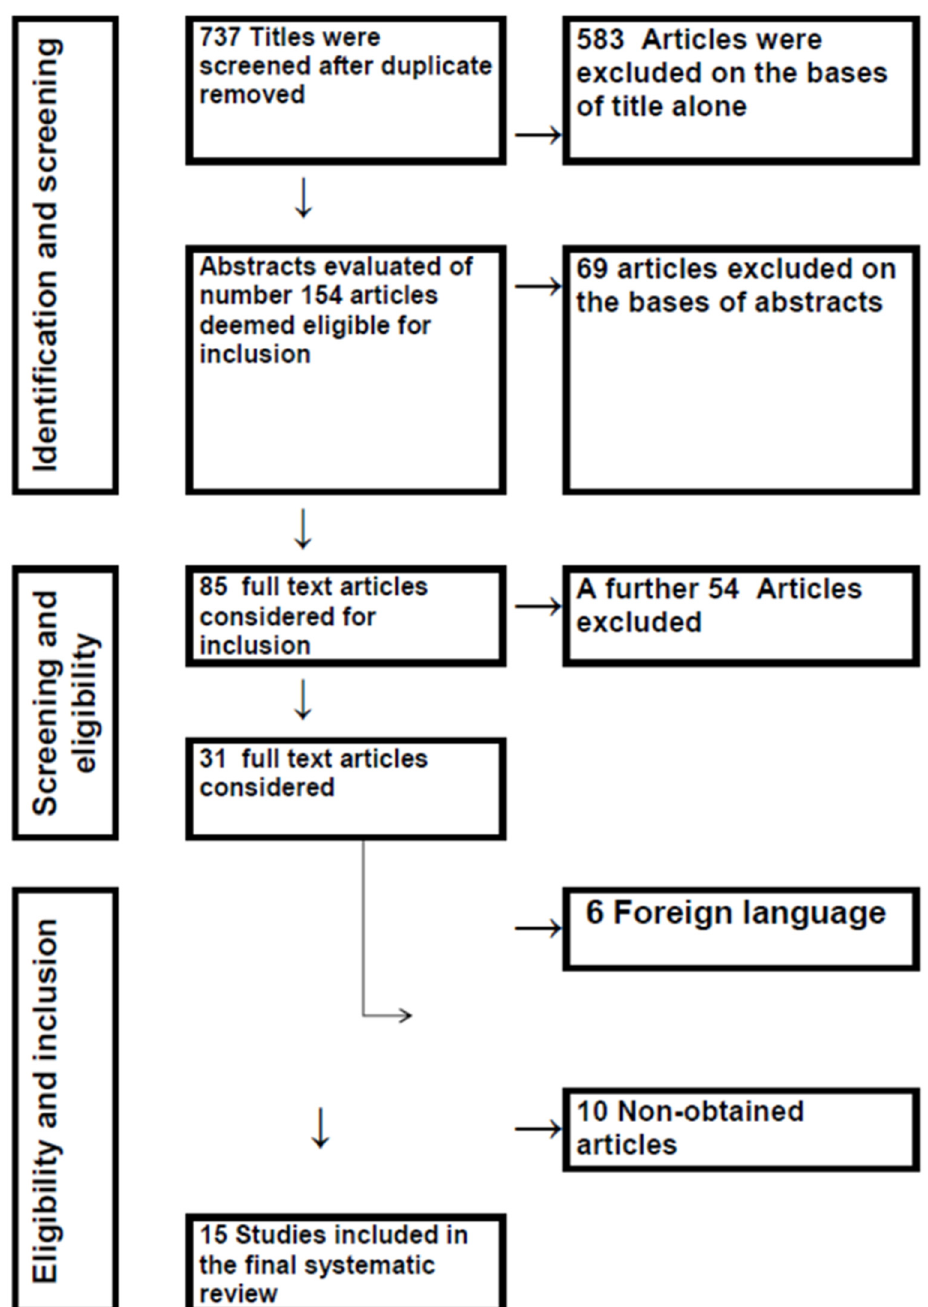
Figure 1. Results of the literature search and disposition of echocardiographic articles screened for inclusion.